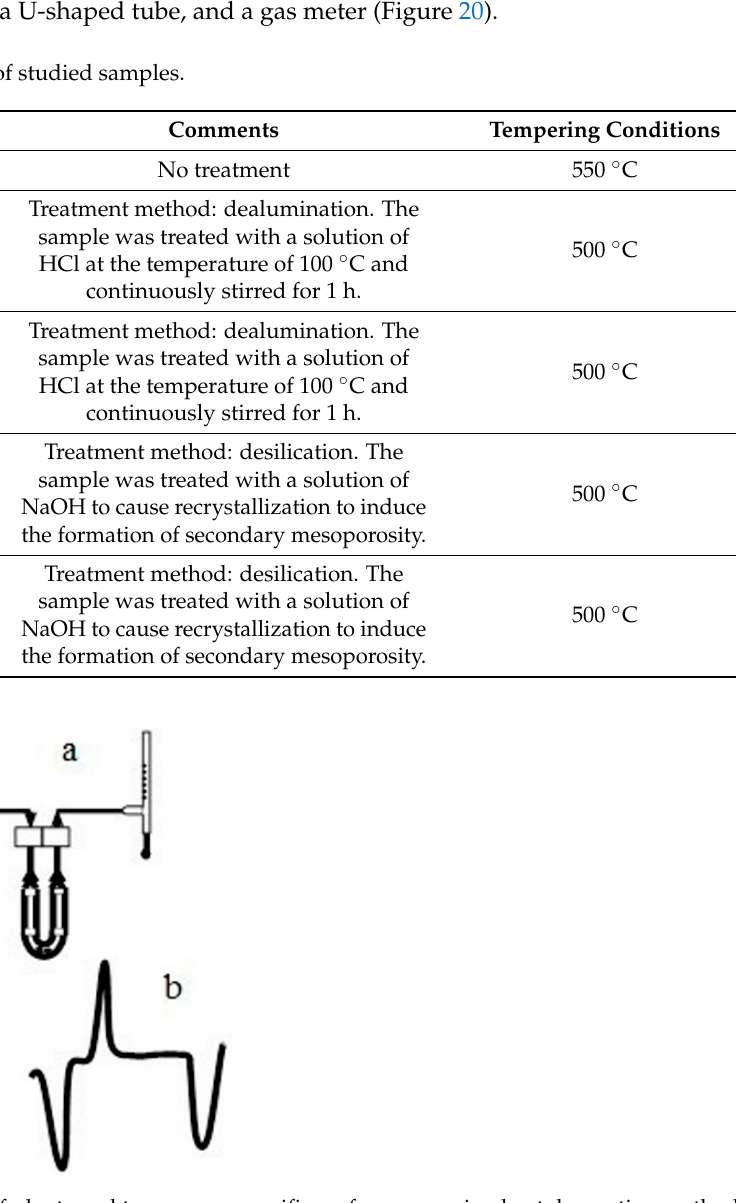
Figure 20. Diagram of plant used to measure specific surface area using heat desorption method ( a ) and adsorption and desorption spikes corresponding to heating and cooling of samples ( b